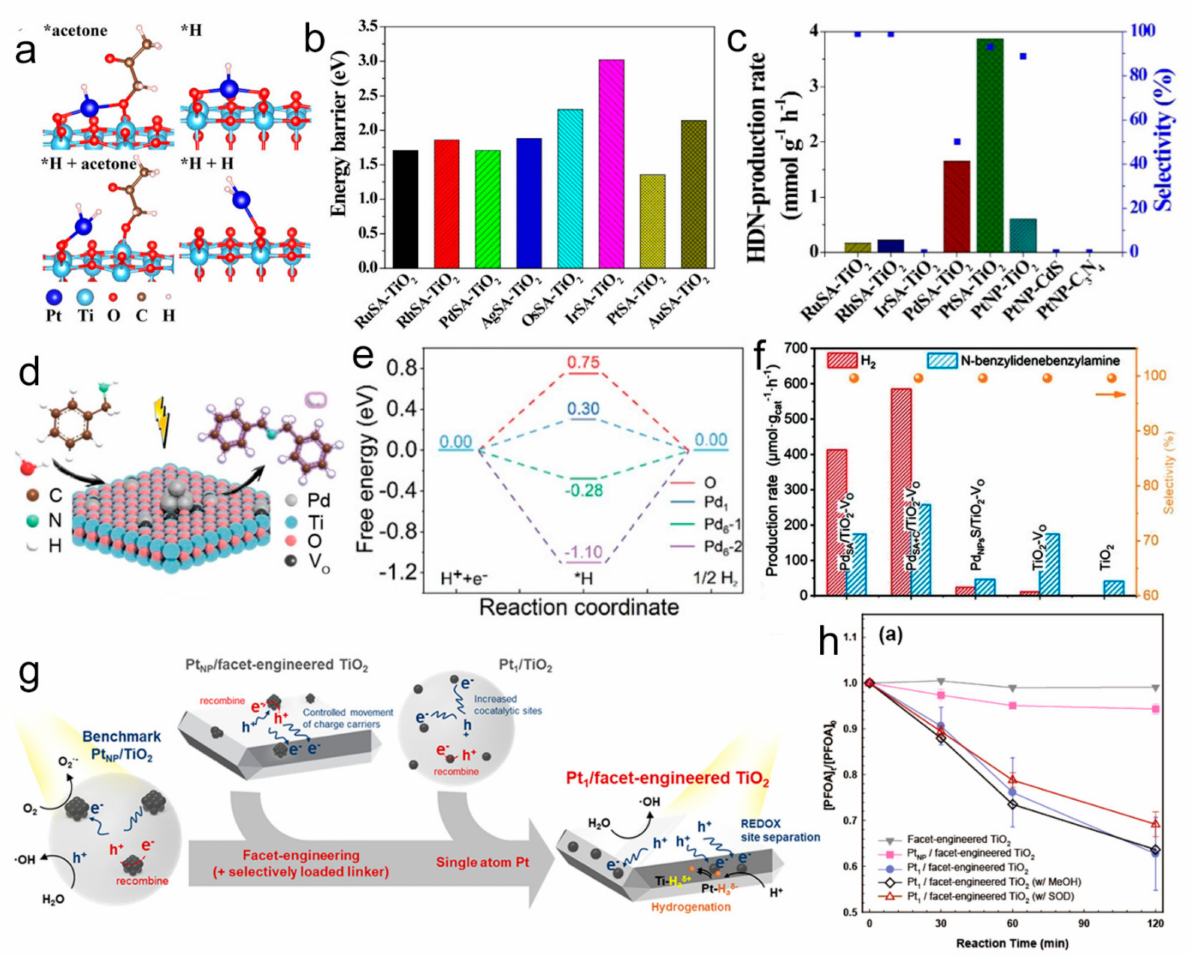
Figure 14. ( a ) Reaction path of acetone dehydrogenation, and ( b ) the corresponding energy barrier on MSA-TiO 2 (M = Ru, Rh, Pd, Ag, Os, Ir, Pt, and Au). ( c ) Photocatalytic HDN-production activity of as-prepared samples from acetone. Adapted with permission from Ref. [46]. ( d ) Schematic diagram of the photocatalytic reaction, ( e ) Free energy profiles for H adsorption on different sites of Pd 1 +Pd 6 /TiO 2 -O V model: O-site near O V , Pd 1 site, Pd 6 -1 site at the Pd 6 -TiO 2 interface, Pd 6 - 2 site on the top of Pd 6 cluster, ( f ) production rates of H 2 (red) and N-benzylidenebenzylamine (blue) over different photocatalysts. Adapted with permission from Ref. [188]. ( g ) Photocatalysis mechanisms of Pt NP-loaded TiO 2 , Pt SA-loaded TiO 2 , Pt NP-loaded facet-engineered TiO 2 , and Pt SA-loaded facet-engineered TiO 2 . ( h ) Photocatalytic degradation of perfluorooctanoic acid (PFOA) using Pt 1 /facet-engineered TiO 2 . Adapted with permission from Ref.